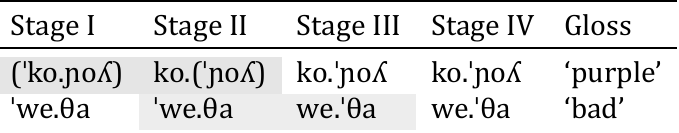
Table 19: Changes in adjectival stress: vowel and consonant (cid:976)inal forms (applicable also to adverbs, pronouns and determiners — key changes in